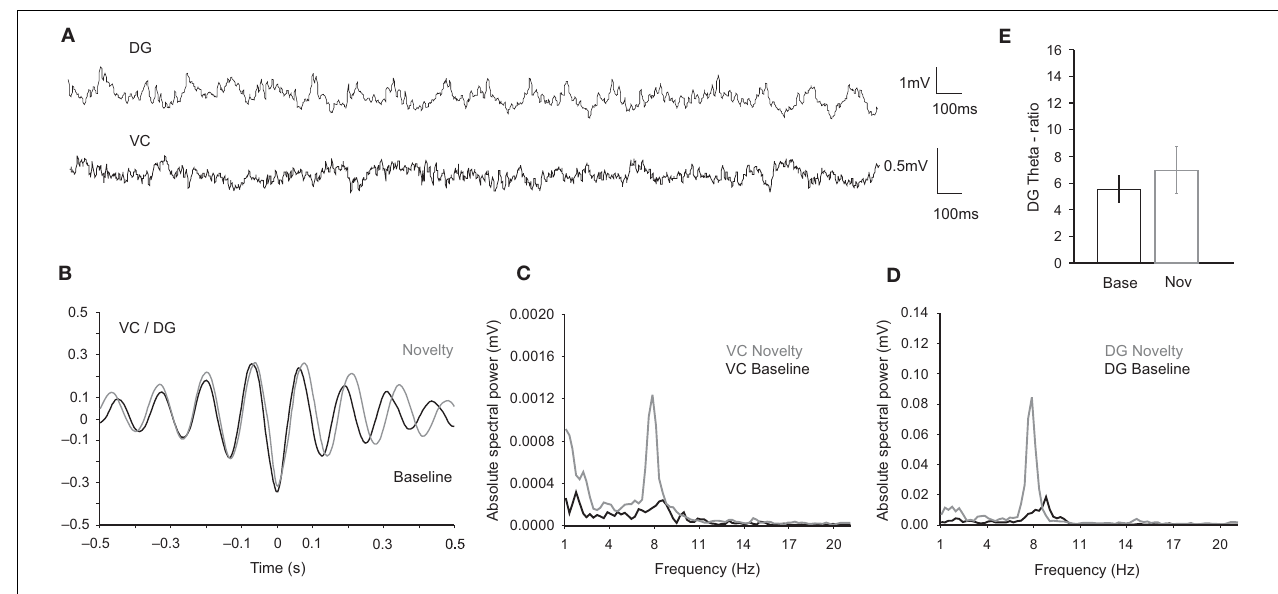
FIGURE 5 | Neural activity in the DG and VC during baseline theta period. (A) Original traces of fi eld potential recordings in the DG (upper trace) and the VC (bottom trace) during baseline theta period (aroused theta, see Materials and Methods). (B) Cross-correlation analyses of activities in the DG and the VC during the baseline theta periods (black trace, n = 4) reveal no signifi cant difference of the waveforms synchronization in comparison to the novelty exploration (grey trace, n = 4). Note a tendency towards a right-shift in the